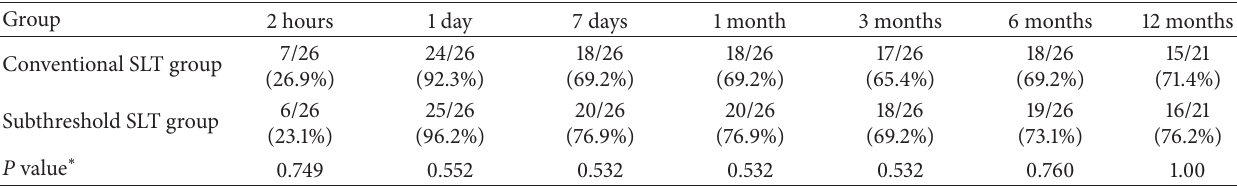
Table 6: Successful cases that reach ≥ 20% decrease in IOP after SLT